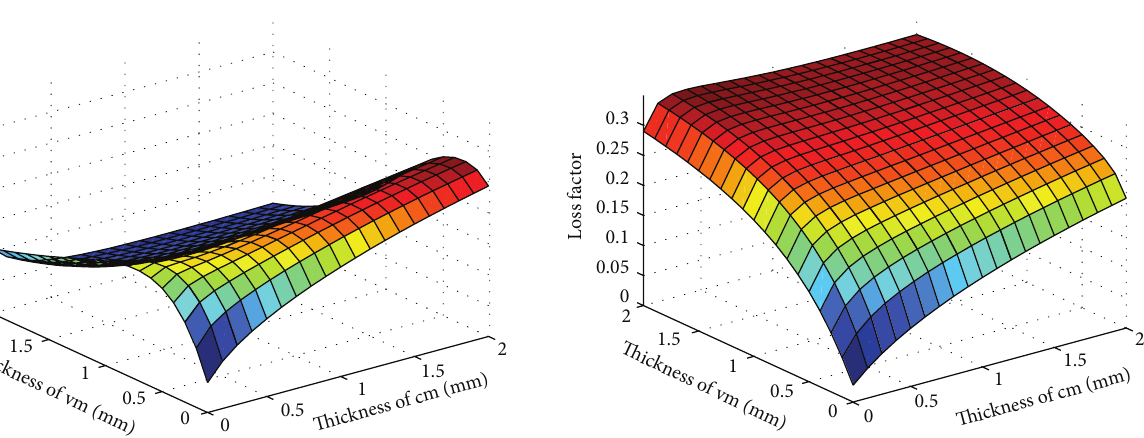
Figure 18: Influence of thickness on the loss factor in 11-layer struc-